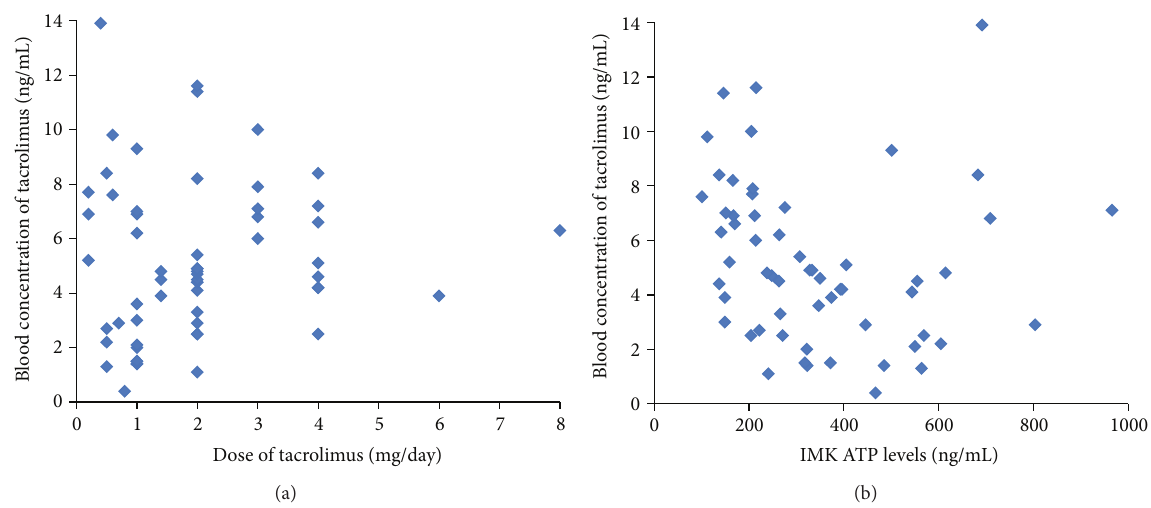
Figure 1: (a) Relationship between the blood concentration of tacrolimus and dosage of tacrolimus after LDLT ( 𝑅 = 0.0806, 𝑃 = 0.1162 ). (b) Relationship between blood concentration of tacrolimus and ImmuKnow ATP level after LDLT ( 𝑅 = 0.1473, 𝑃 = 0.2745 ).